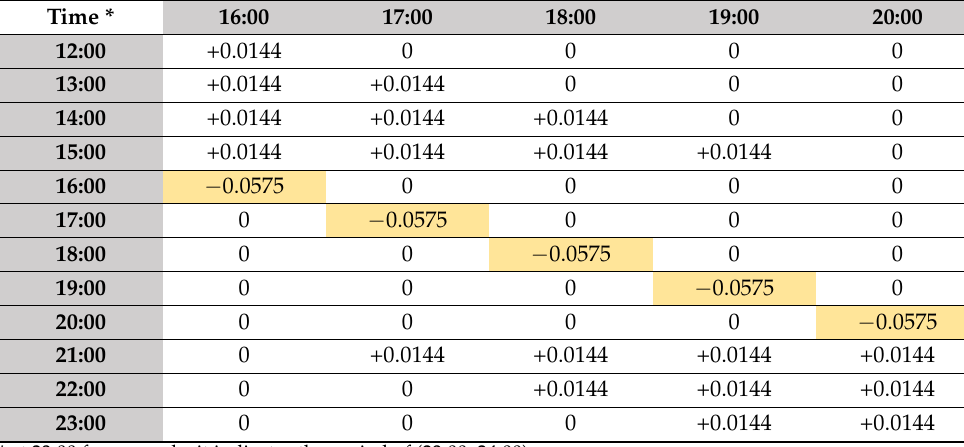
Table 10. Base self-elasticity, lossless PEMD with no AC shifting scenario.